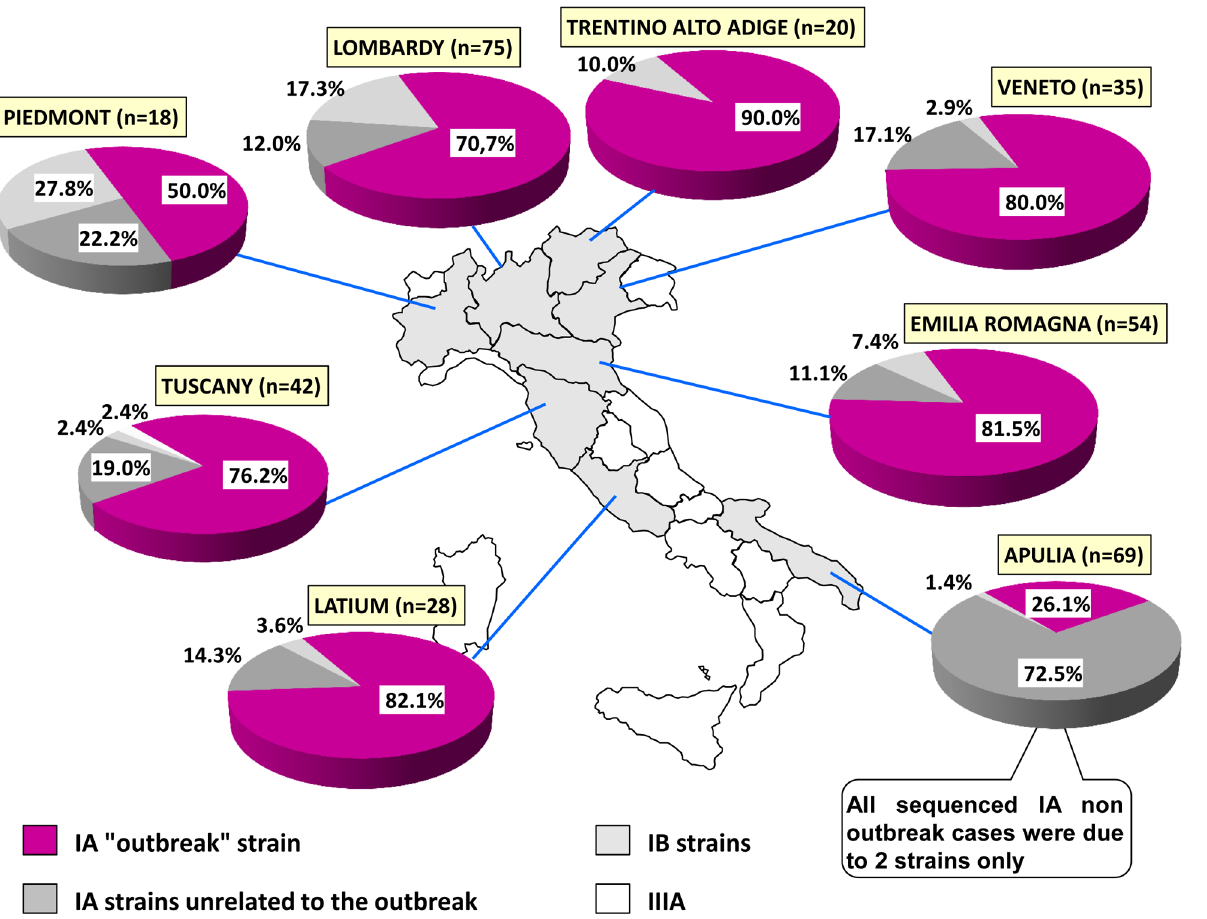
Fig 2. Distribution of HAV strains in the 8 Italian Regions for which enough sequences were